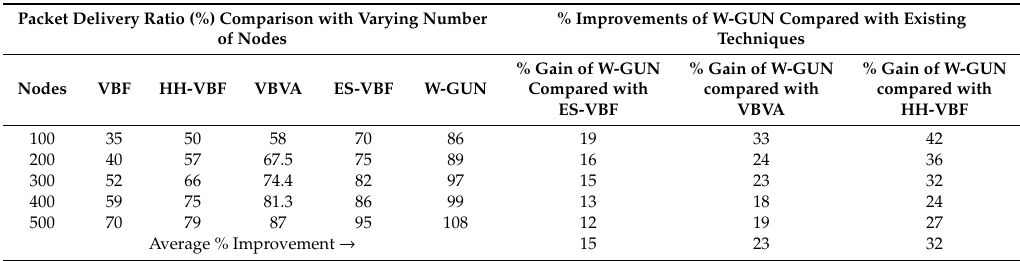
Figure 6. Detailed percentage-centric performance gain of W-GUN focusing packet delivery ratio. Table 2. Descriptive performance observation of W-GUN in terms of packet delivery